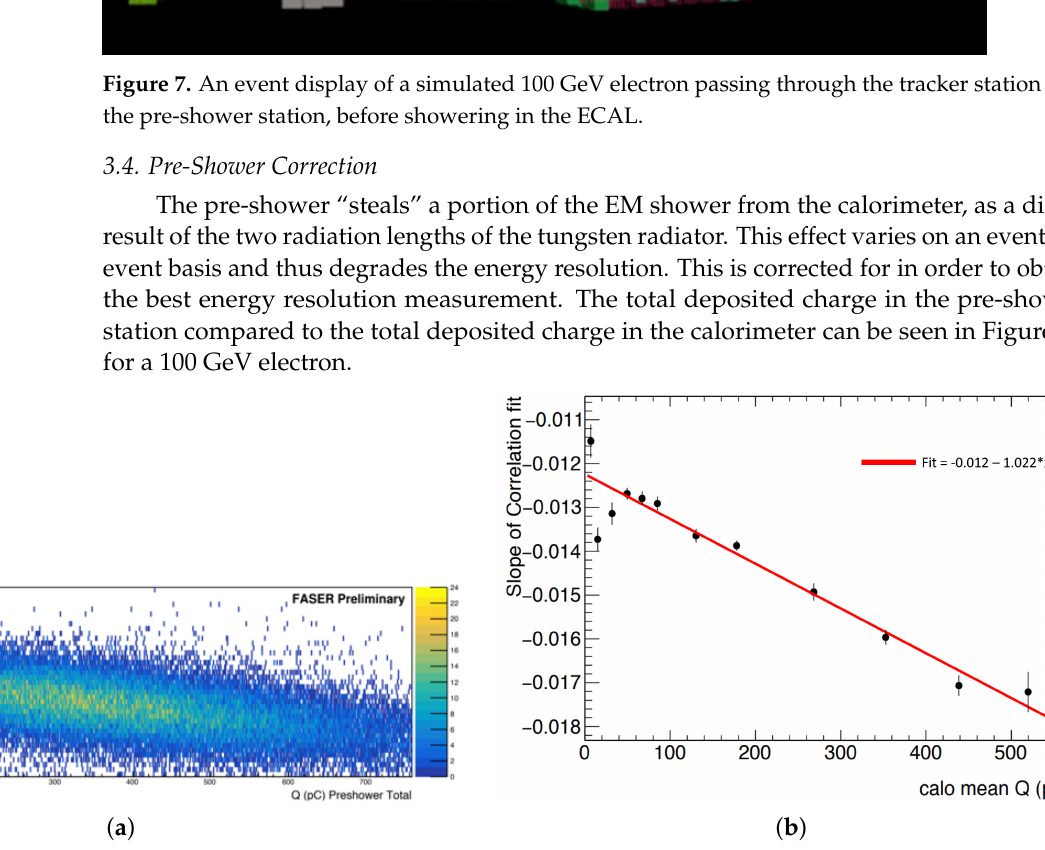
Figure 8. ( a ) The deposited charge in the pre-shower versus calorimeter for 100 GeV electron. ( b ) The slope of correlation fit between charge deposits in the pre-shower and calorimeter, as a function of the mean deposited charge in the calorimeter for electrons with an incident beam energy of 10–300